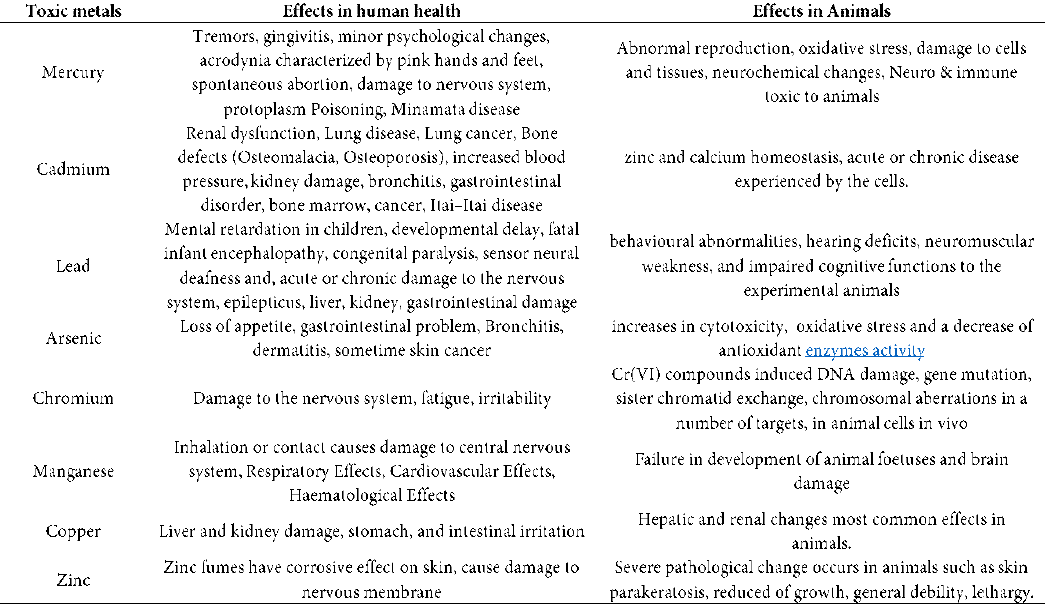
Table 1. List of some toxic metal ions and their biological effects on humans and